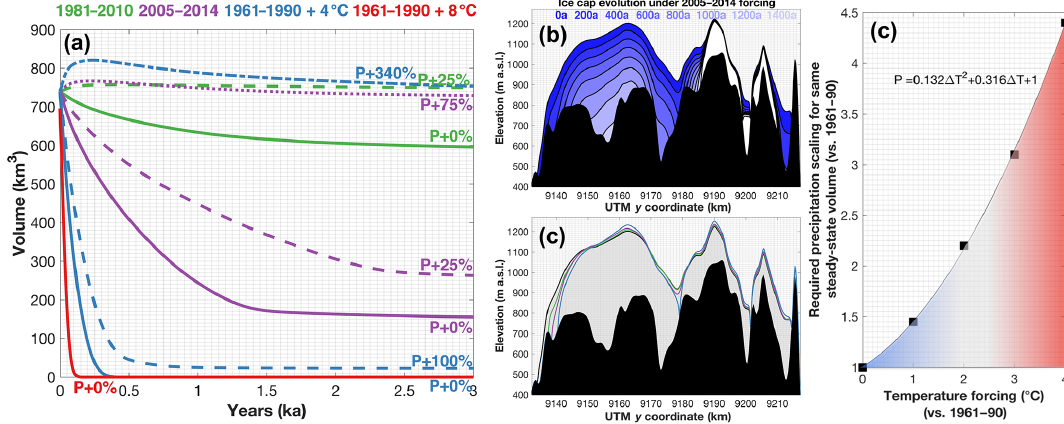
Figure 11. (a) Volume evolution of Hans Tausen Iskappe under different climatic conditions. The solid lines represent simulations where the precipitation is unaltered (i.e. P + 0%), while the dotted lines represent simulation with a modified precipitation. The starting point of all simulations is the 1961–1990 steady-state geometry. (b) Evolution of the Hans Tausen Iskappe along UTM x = 602 . 5km transect under the 2005–2014 forcing, starting from the 1961–1990 steady state, for 200-year time intervals. The black area represents the bedrock, and the white area represent the final steady-state geometry. The location of the transect is shown in Fig. 5. (c) Temperature forcing and corresponding precipitation forcing (scale factor) needed for 1961–1990 steady-state volume to be preserved. The polynomial fit is based on five simulations (1961–1990 + 0/1/2/3/4 ◦ C), which are represented by the black dots. The blue area broadly corresponds to the range where an attenuation of the mass loss is possible, while the red area represents the range under which the ice cap is to (largely) disappear. (d) Ice cap profiles along the UTM x = 602 . 5km transect. The shaded grey area is the 1961–1990 steady-state ice cap geometry. The three other geometries correspond to the 1981–2010 ( P + 25%), 2005–2014 ( P + 75%) and 1961–1990 + 4 ◦ C ( P + 340%) steady states and follow the same colour scheme as in (a) . The location of the transect is shown in Fig.